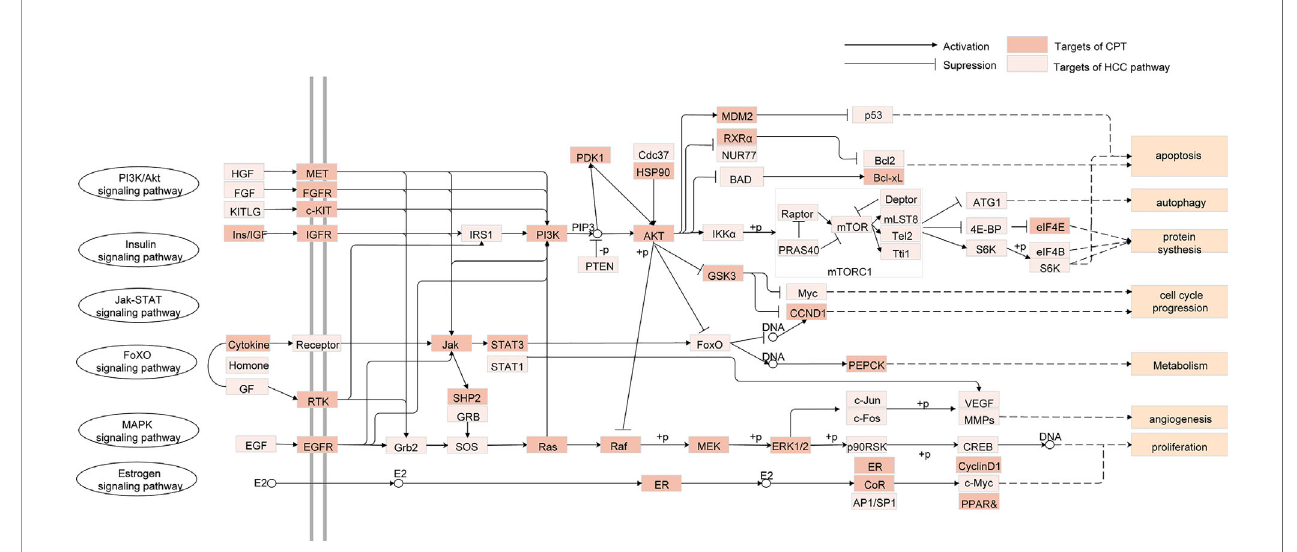
FIGURE 5 | Integrated human hepatocellular carcinoma (HCC)-pathway and functional